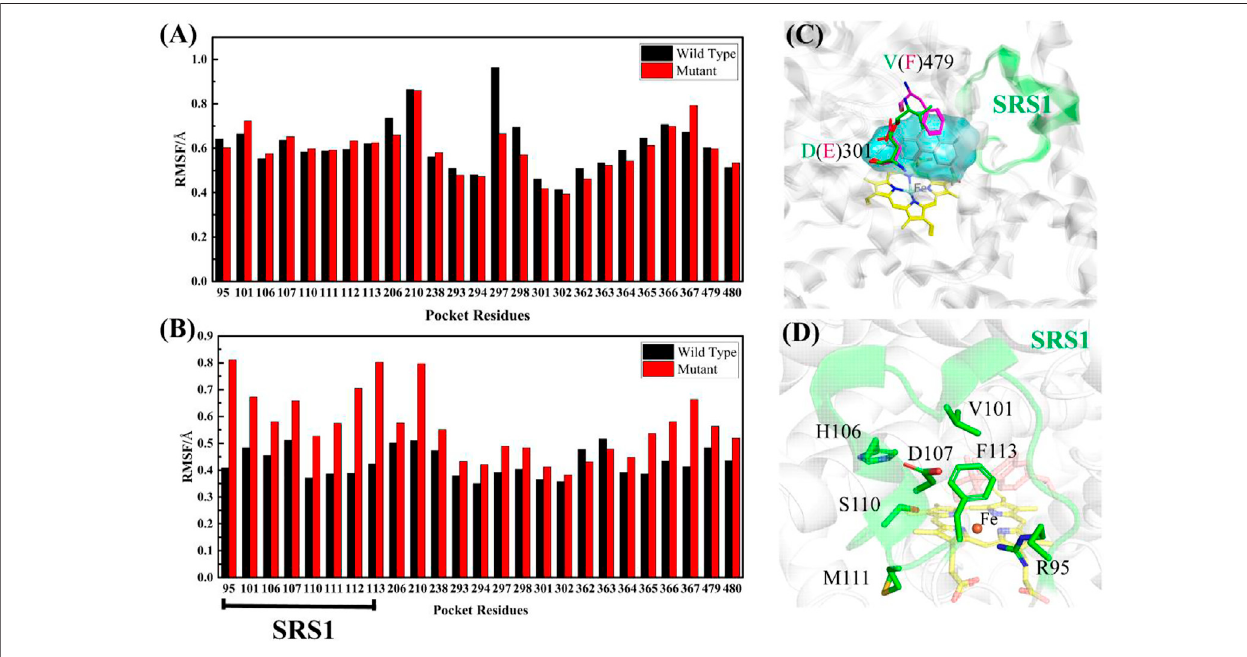
FIGURE 2 | (A) Comparison of RMSF values of pocket residues between wt-apo-Rest and mut-apo-Rest systems. (B) Comparison of RMSF values of pocket residues between wt-abi-Rest and mut-abi-Rest systems. (C) Illustration of the active pocket and the two mutant residues in CYP76AH1. (D) Illustration of the fl exible SRS1 region and the reactive center Fe.